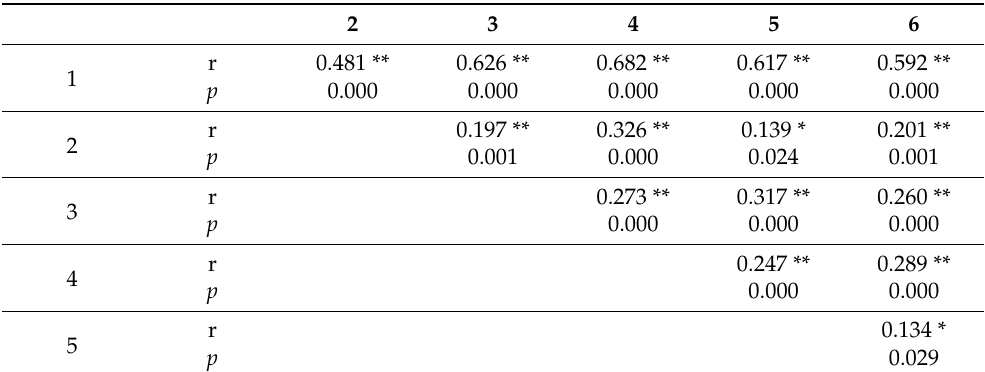
Table 4. Correlations between SOTG domains scores for the U20 division ( n =